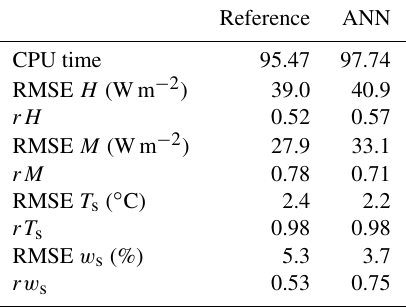
Table 9. Same as Table 8, but for the forest station